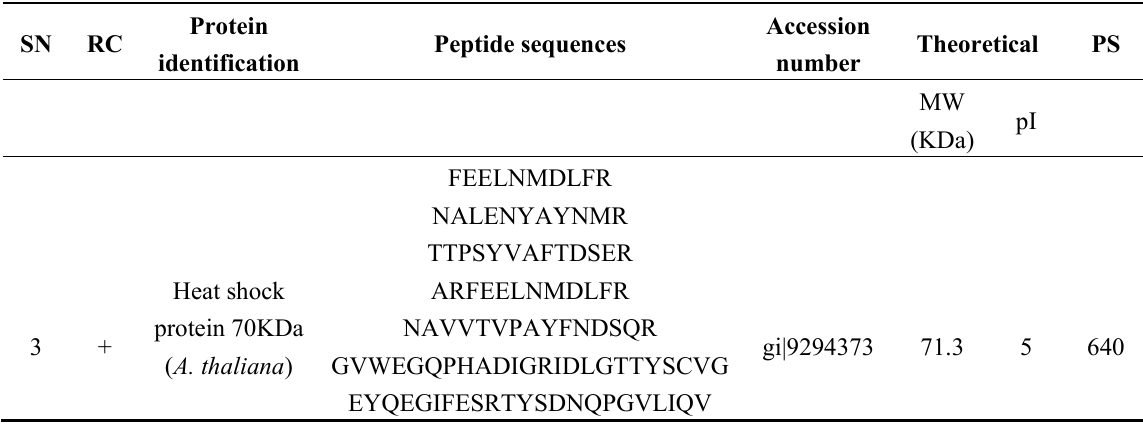
Table 2. Identification of protein spots that show significant differences in synthesis level between fortified and control plants.